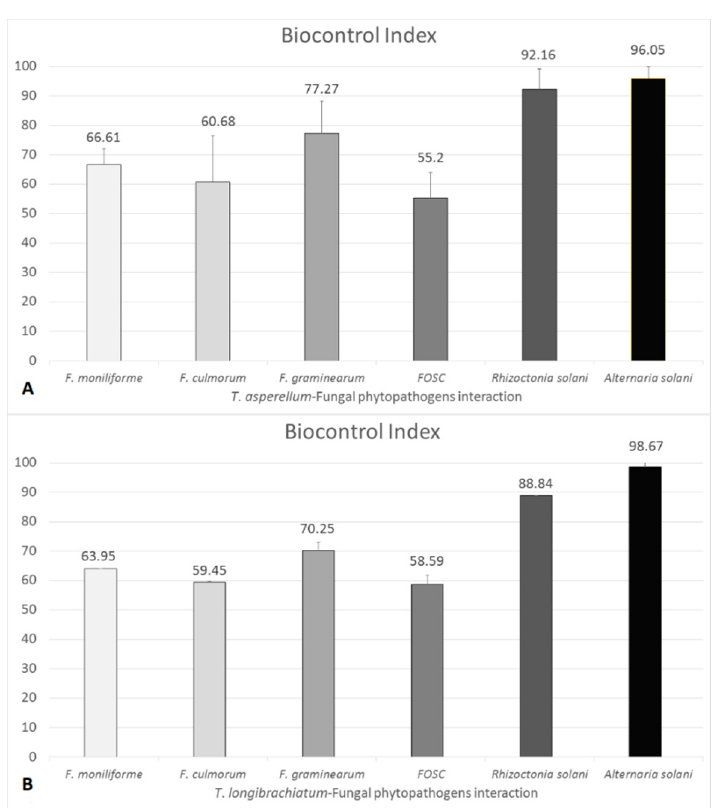
Figure 4. Biocontrol index (BCI) values of Trichoderma asperellum IRAN 3062C ( A ) and Trichoderma longibrachiatum IRAN 3067C ( B ) towards different plant pathogenic fungi. Bars represent standard deviation.